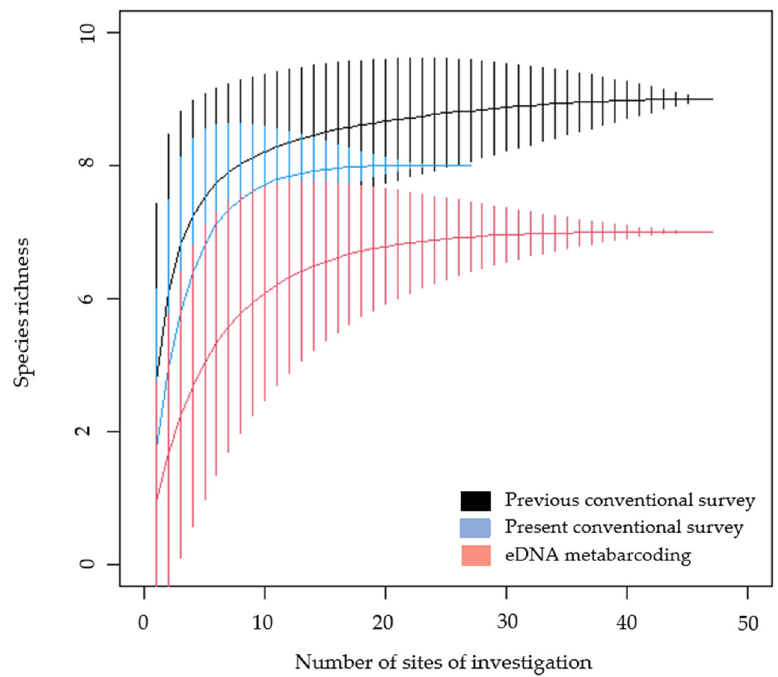
Figure 2. An accumulative curve of species richness detected by applied survey methods in the present and previous studies [25,26]. Vertical lines represent standard deviation. n = 27 for the conventional survey in the present study, while n = 47 for the conventional survey in previous studies and eDNA metabarcoding of the present study.